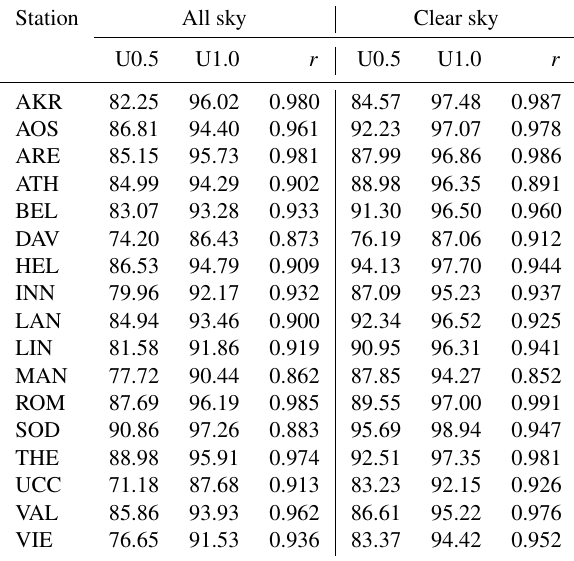
Table 3. Absolute difference between UVIOS and ground-based UVI measurements in terms of percentages (%) of data that are within 0.5 and 1 UVI of difference (U0.5 and U1.0, respectively) as well as the correlation coefficient ( r ) for all-sky and clear-sky